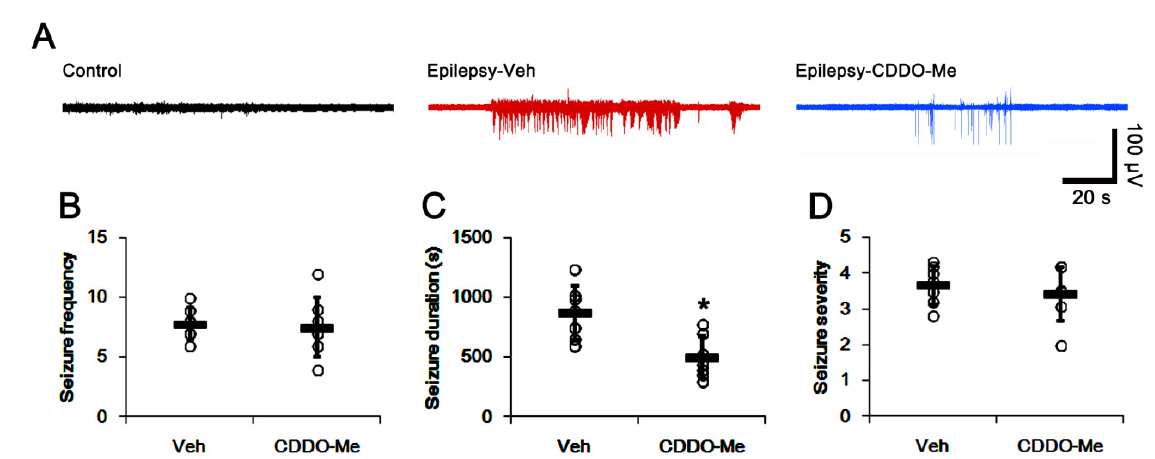
Figure 7. Effects of CDDO-Me on spontaneous seizure activity in epileptic rats. CDDO-Me treatment reduces seizure duration, but not seizure frequency and its severity in epileptic rats. ( A ) Representative EEG traces obtained from control and epileptic rats. ( B – D ) Quantitative values of total seizure frequency ( B ), total seizure duration ( C ) and seizure severity ( D ) over a 4-day period. Open circles indicate each individual value. Horizontal bars indicate mean value. Error bars indicate SD ( * p < 0.05 vs. vehicle (Veh)-treated animals; Mann–Whitney U-test for seizure frequency and seizure severity; Student t -test for seizure duration; n = 7).